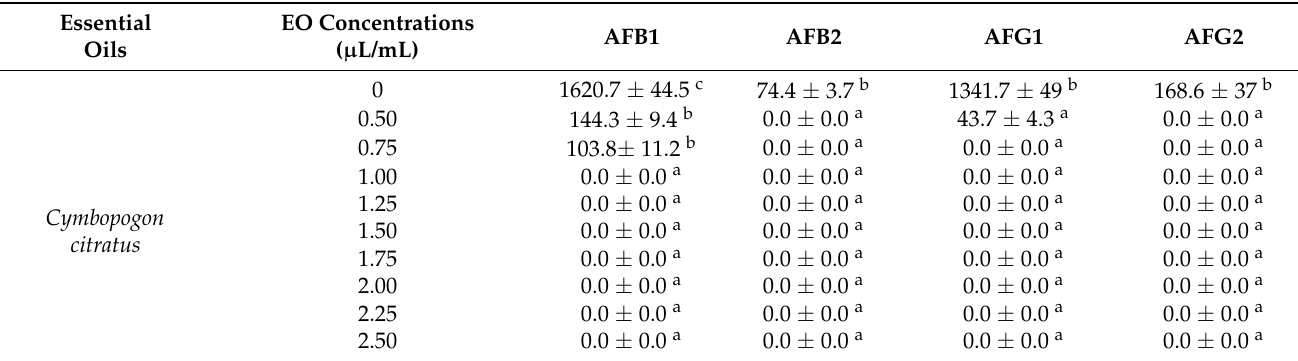
Table 7. Effect of C. citratus essential oil on aflatoxin production ( µ g/kg) after 7 days exposure to different concentrations.